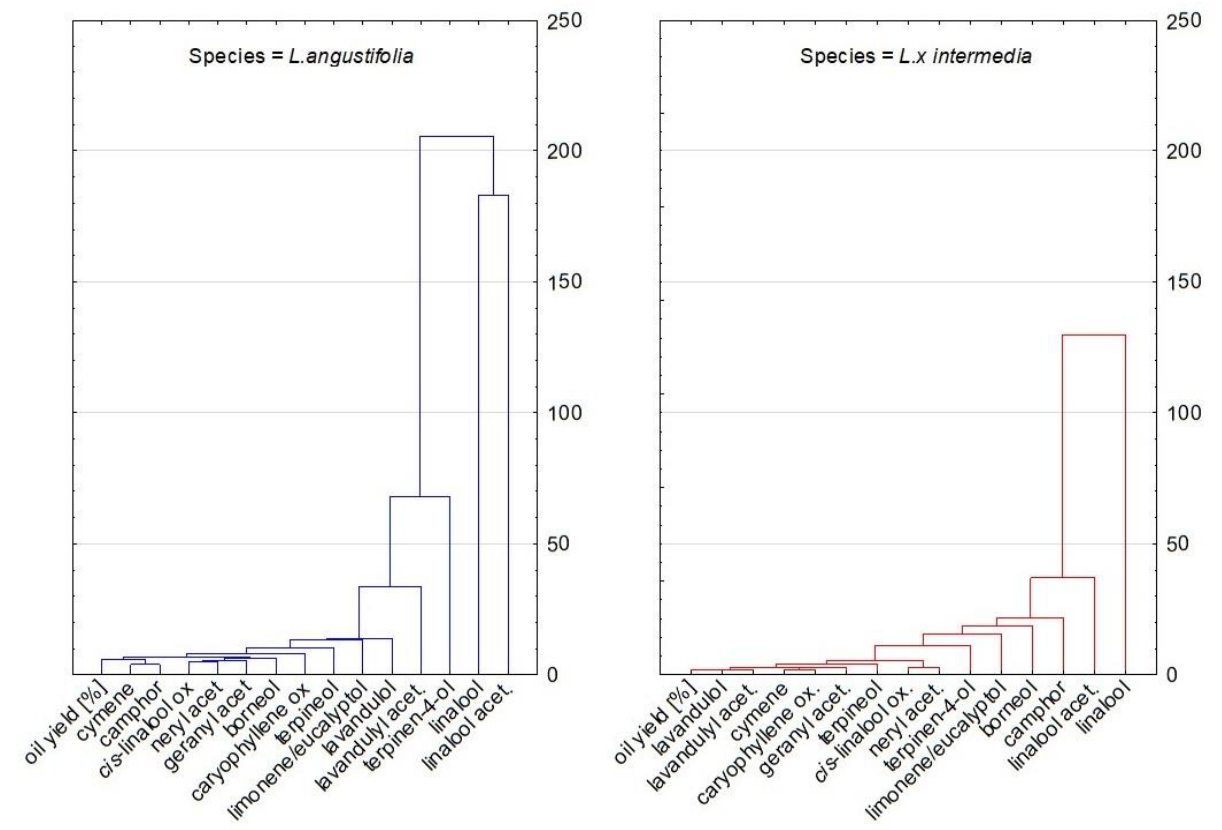
Figure 8. Dendrograms obtained via the HCA analysis of all obtained data based on average content of EO components in species.